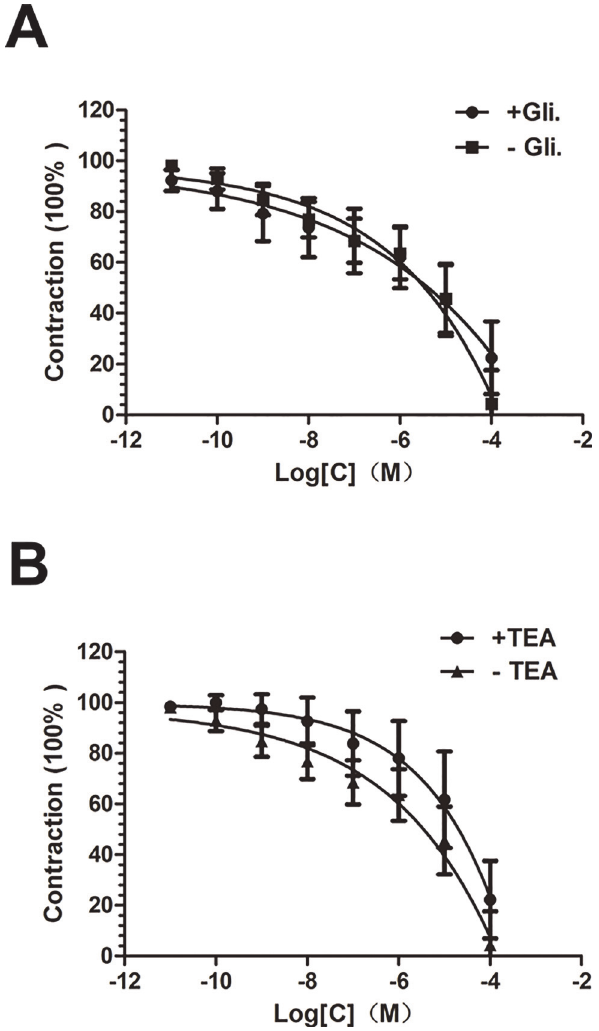
Fig 7. Role of potassium channel in compound 1-induced relaxation. A. Role of glibenclamide (10 − 5 mol (cid:1) L -1 ) on no-endothelium aortic rings pre-stimulated by PE(10 – 6 mol (cid:1) L -1 ) in the vasodilation induced by compound 1 . B. Effect of TEA (5x10 − 6 mol (cid:1) L-1) on compound 1 vasodilation. Data are showed as mean ± S.E.M., n =